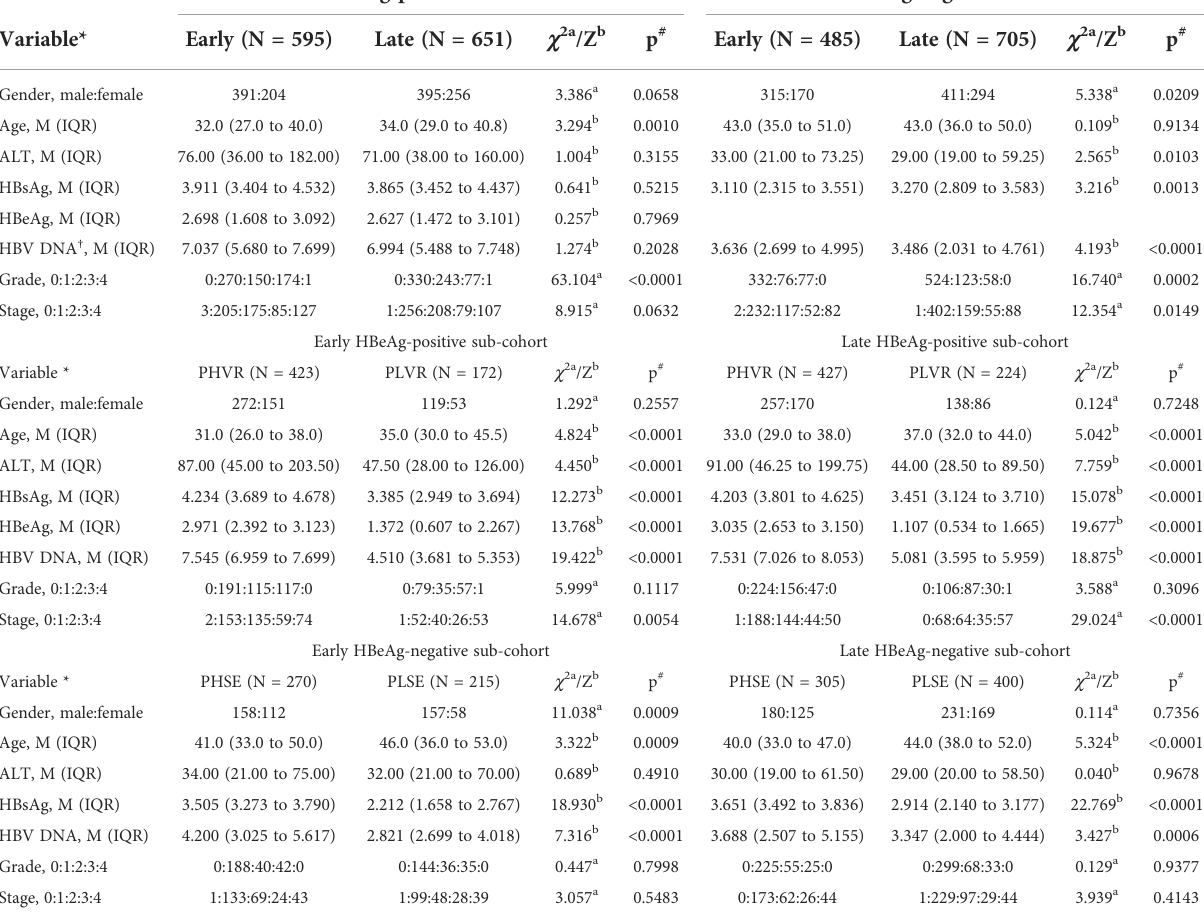
TABLE 1 Demographic, laboratory, and pathological characteristics of study subjects. HBeAg-positive cohort HBeAg-negative